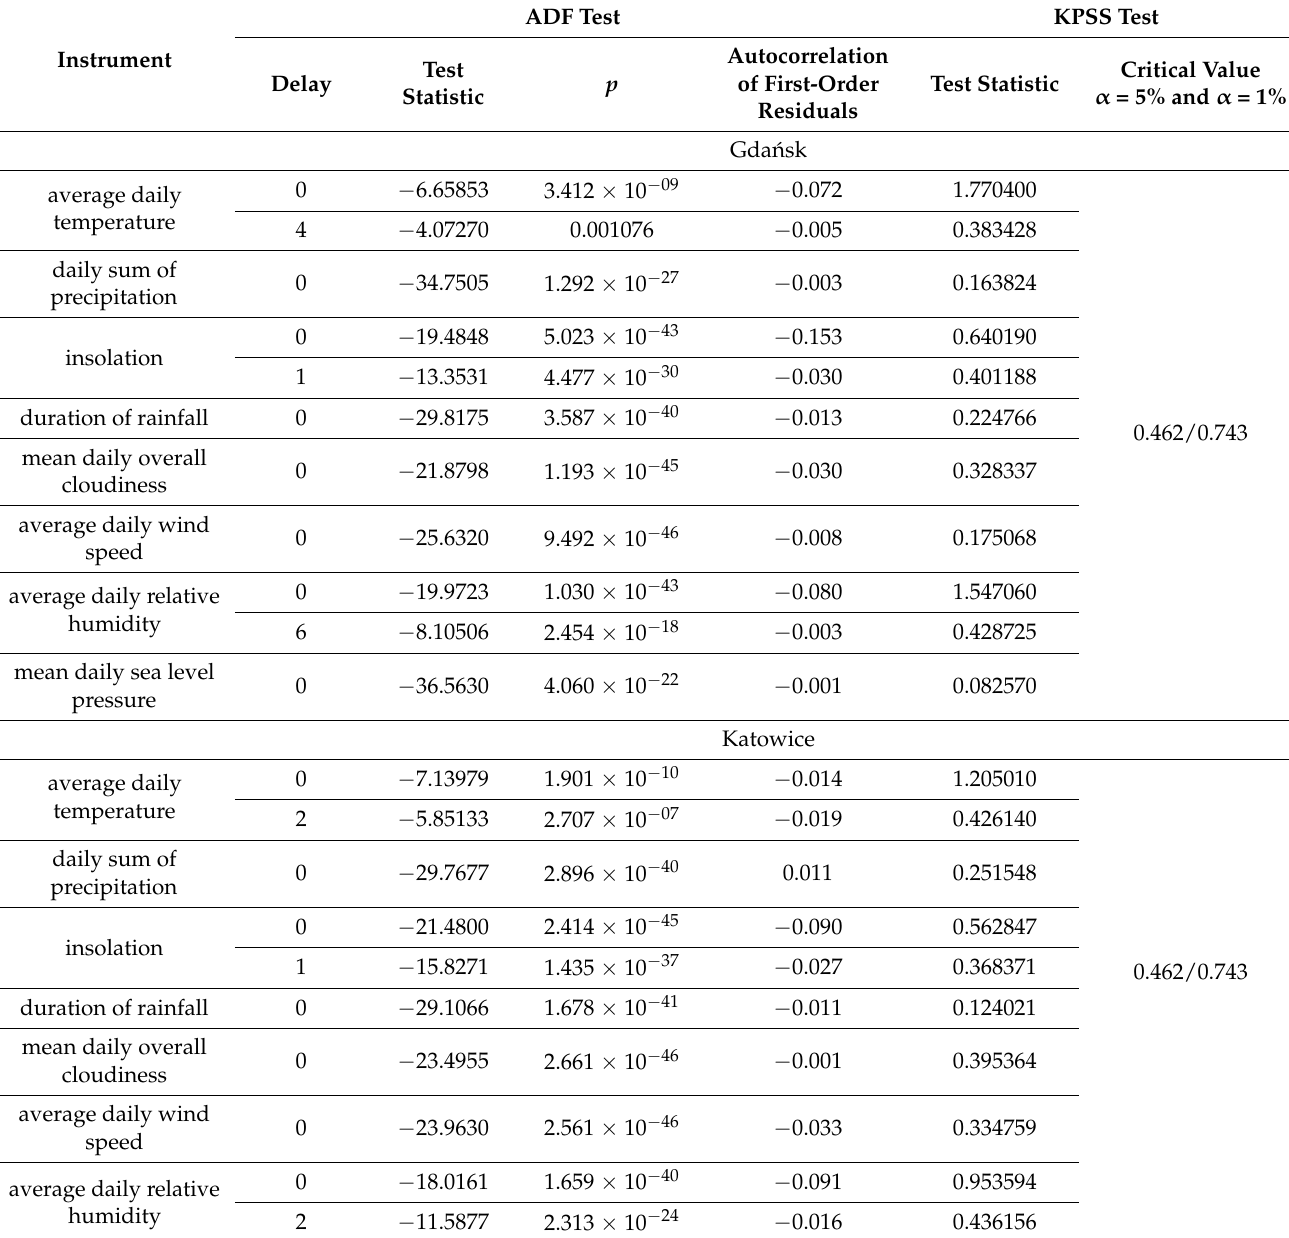
Table 3. Results of stationarity tests of the analyzed weather time